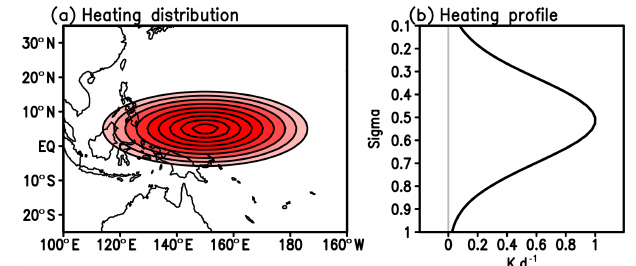
Figure A1. (a) Horizontal distribution of the heating given to force the LBM/AGCM at the 0.5 σ level. Contour is drawn from 0.1 to 0.9Kd − 1 with an interval of 0.1. (b) Vertical profiles of the heating at the location of maximum heating (5 ◦ N and 150 ◦ E).